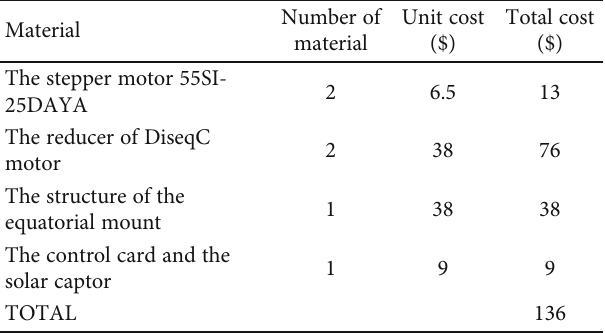
Table 6: Cost of di ff erent components of the proposed concept.